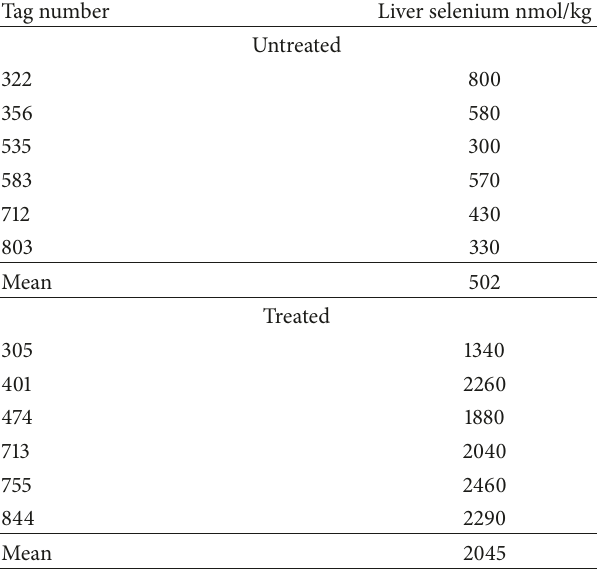
Table 3: Liver selenium concentrations from weaner mixed sex red deer individually identified into untreated and treated groups. The latter group was dosed per os with Exodus Pour-On and Oxfen C Plus 50/50 mixture at 1ml/5 kg.